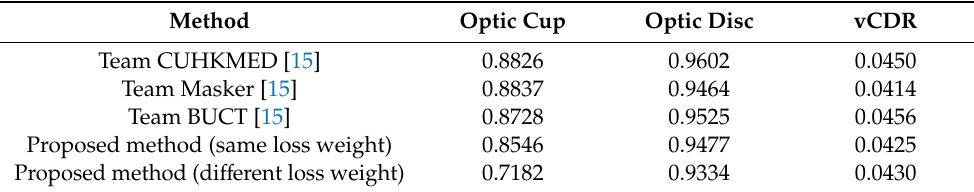
Table 4. Comparing segmentation accuracy.